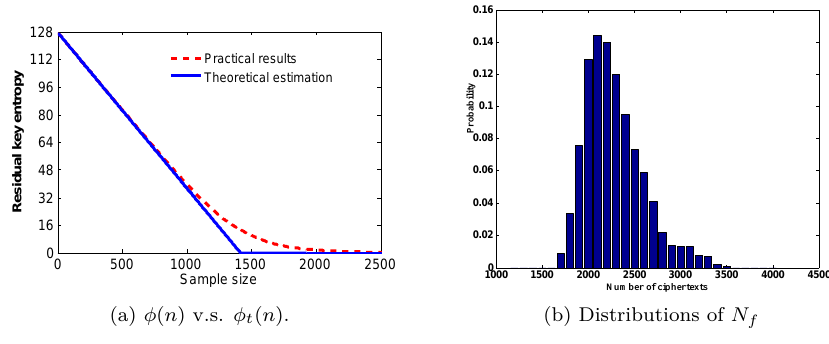
Figure 5: Attack result of PFA on unprotected